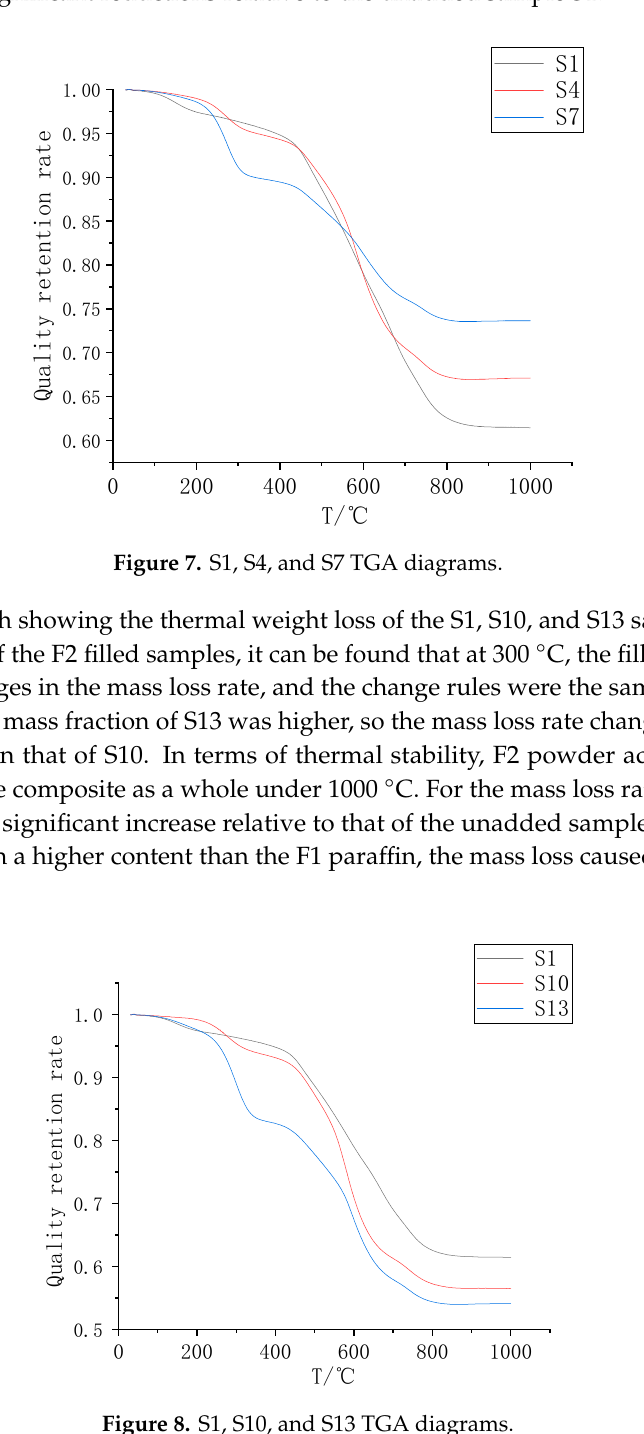
Figure 8. S1, S10, and S13 TGA diagrams.